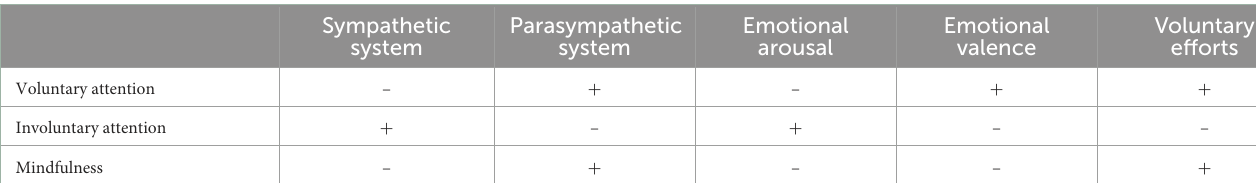
TABLE 1 Differences among three kinds of